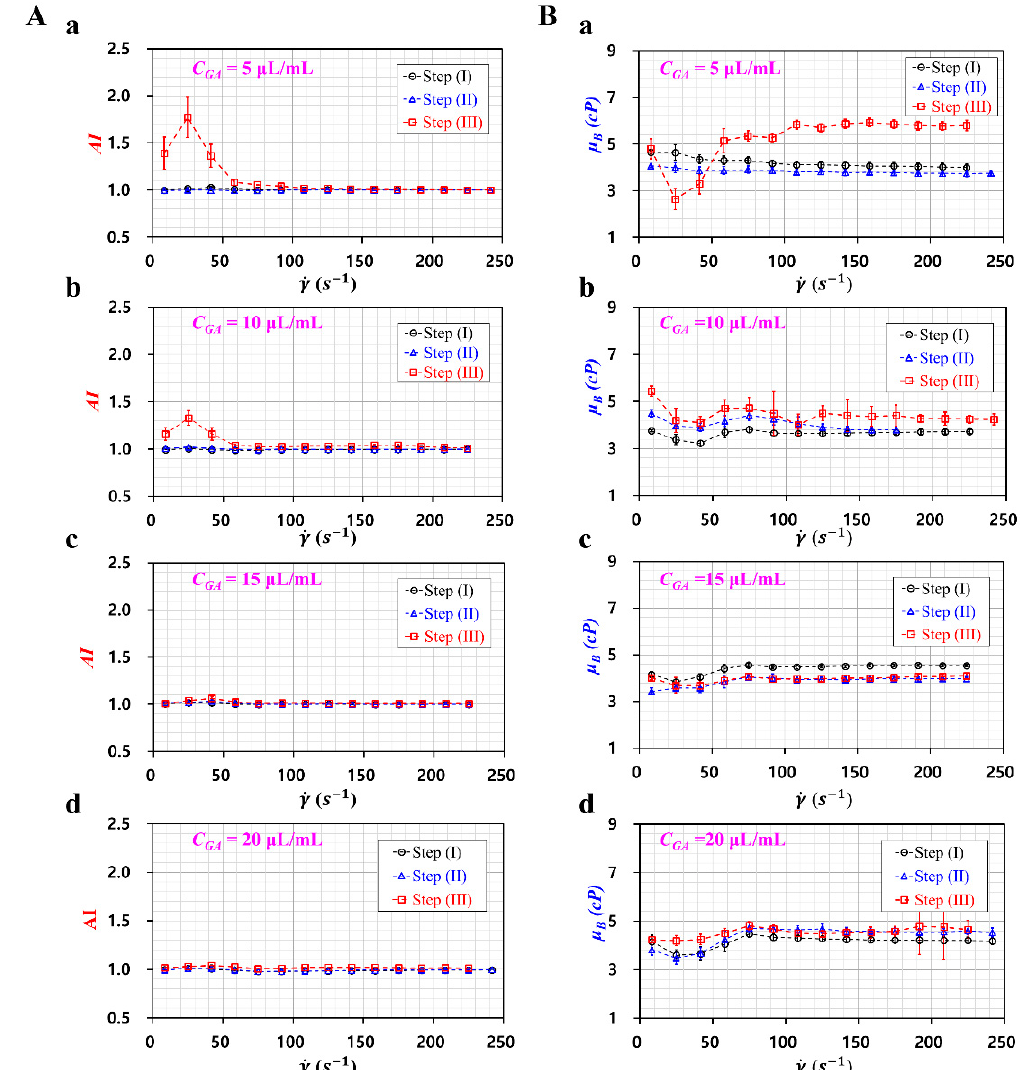
Figure 8. Quantitative evaluations of AI and blood viscosity for fixed blood sample with different diluents with respect to step (I, II, and III). (A) Variations of AI with respect to C GA (( a) C GA = 5 μ L/mL, ( b) C GA = 10 μ L/mL, ( c) C GA = 15 μ L/mL, and ( d) C GA = 20 μ L/mL) and shear rate. (B) Variations of μ B with respect to C GA (( a) C GA = 5 μ L/mL, ( b) C GA = 10 μ L/mL, ( c) C GA = 15 μ L/mL, and ( d) C GA = 20 μ L/mL) and shear rate.